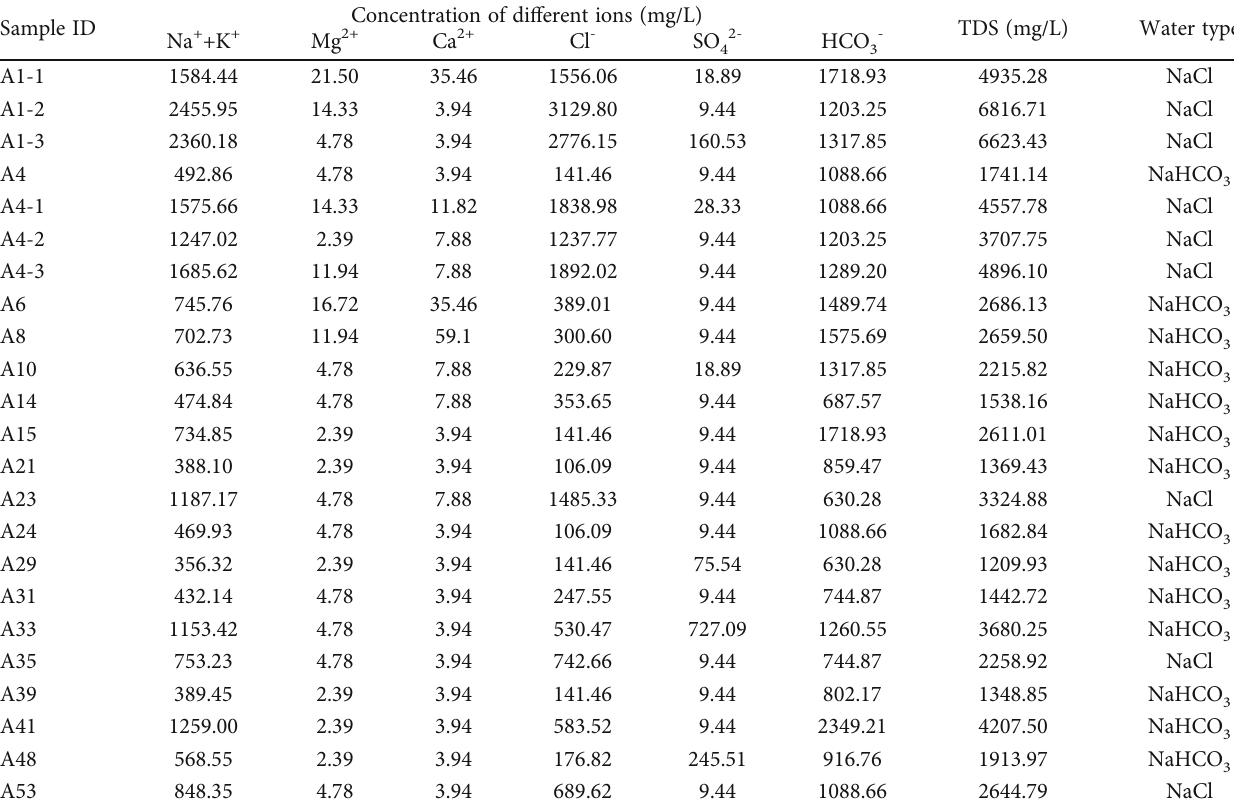
Table 1: The ion concentration and TDS of groundwater in Anze Block.